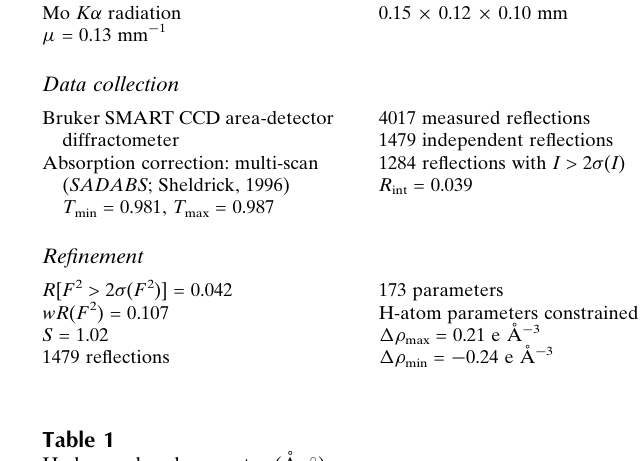
Hydrogen-bond geometry (A˚ , (cid:3)